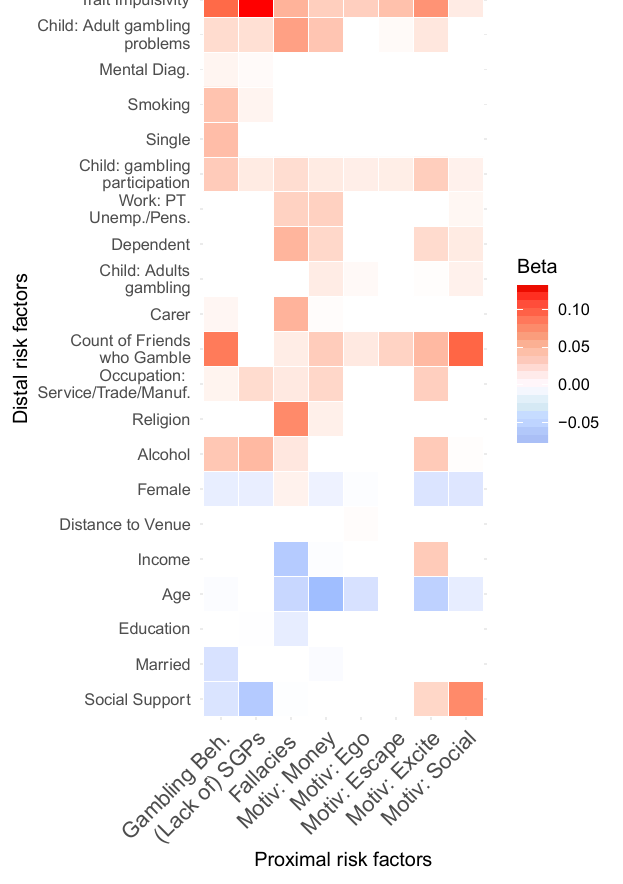
Figure 1. Elastic net regression coefficients on each of the proximal risk factors. Red indicates a positive relationship (greater risk) and blue indicates a negative relationship (less risk). Table 3. Bivariate correlations, OLS and EN multivariate regressions of proximal risk factors on gambling-related harm, and OLS multivariate regression of proximal risk factors on PGSI. log(PGSI + 1) SGHS OLS EN Cor. (Spear.)